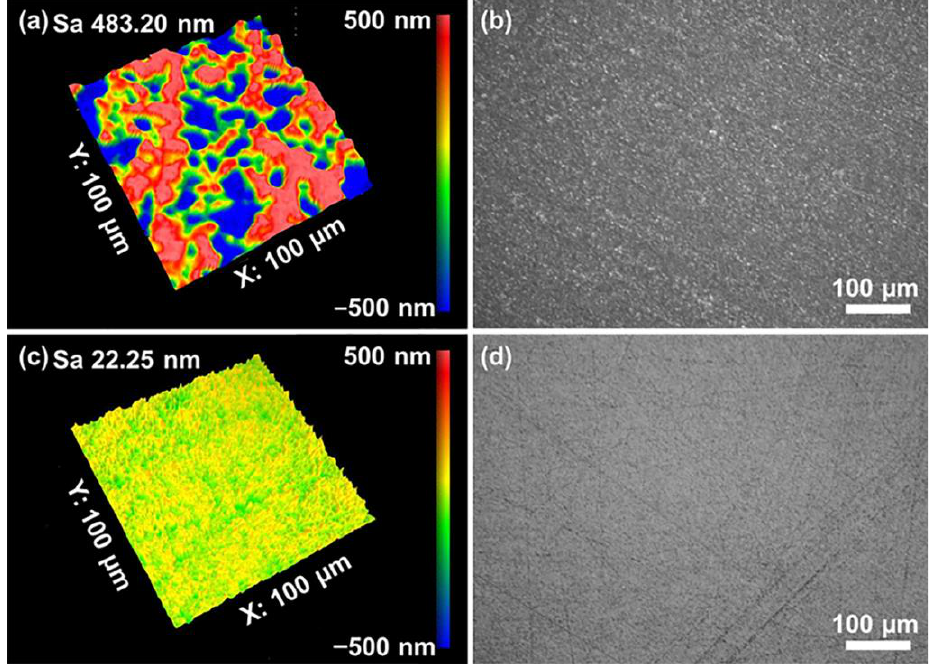
Figure 1. Surface morphology of quartz glass ( a , b ) before and ( c , d ) after